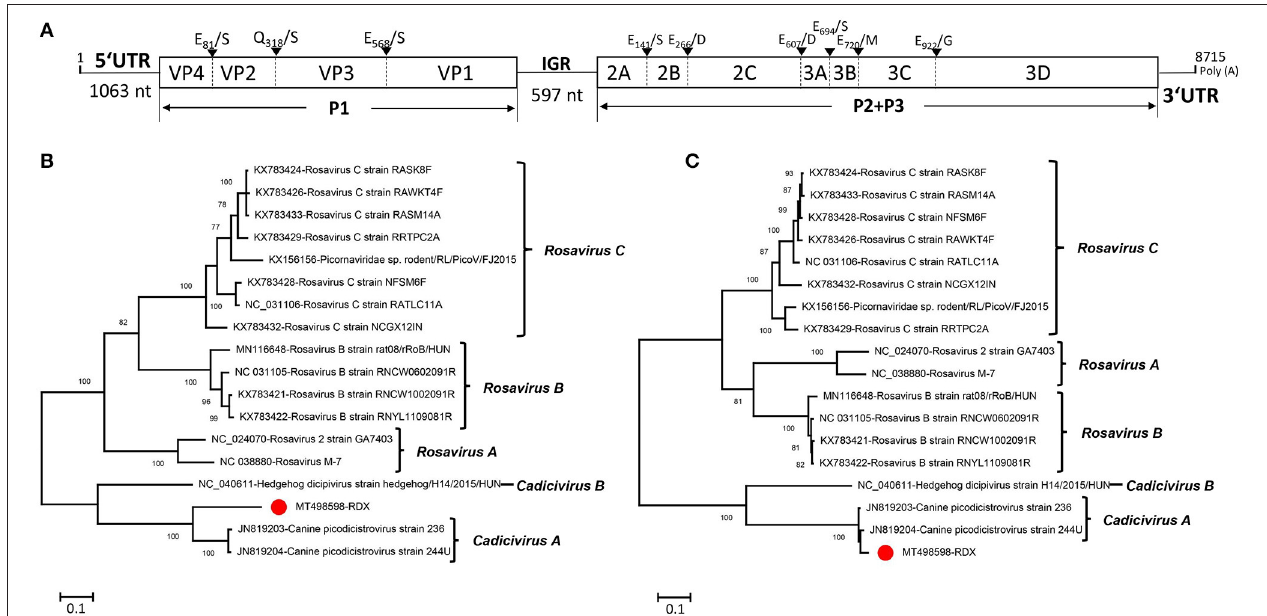
FIGURE 3 | Genomic organization and phylogenetic analysis of the novel dicipivirus identified in raccoon dogs. (A) Genomic organization and predicted protein cleavage sites of RDX. The open reading frames and viral encoding proteins of RDX were drawn. The protein cleavage sites of the RDX strain was obtained through comparing to canine picodicistrovirus (JN819204). IGR, intergenic region; nt, nucleotide; UTR, untranslated region. (B) Phylogenetic analysis based on the amino acid sequences of P1 of RDX and reference strains of the genus Cadicivirus and Rosavirus in the family Picornaviridae . (C) Phylogenetic analysis based on the amino acid sequences of P2 + P3 of RDX and reference strains of the genus Cadicivirus and Rosavirus in the family Picornaviridae . The RDX identified in this study was marked with a red solid